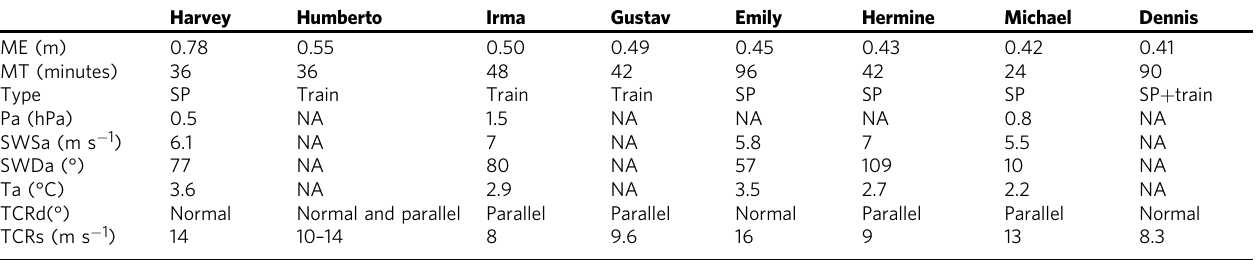
Table 1 Tropical cyclone-induced meteotsunamis and associated atmospheric conditions.